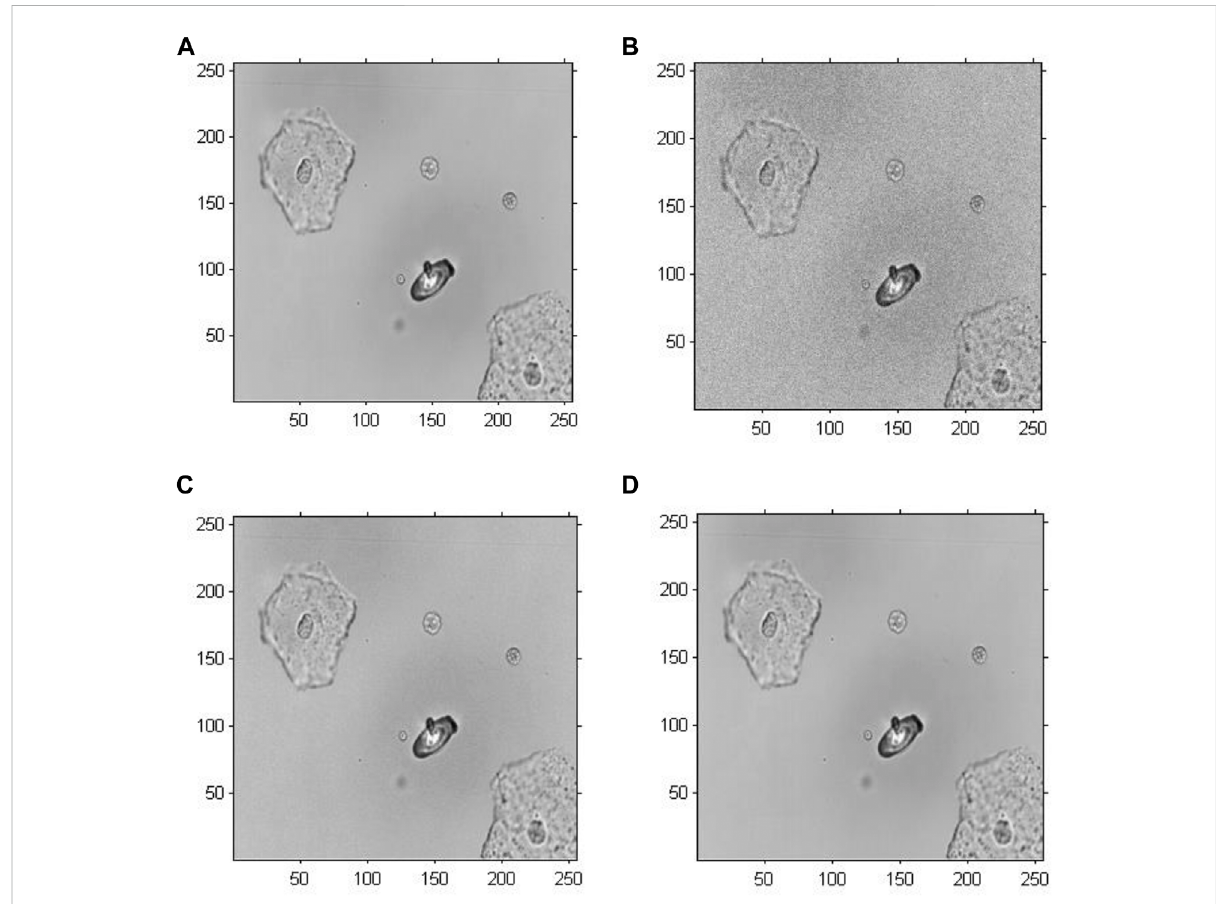
FIGURE 5 Amplitude reconstruction-based holographic image for Model 1. (A) Original greyscale image, (B) 20 iterative reconstruction images of amplitude information, (C) 200 iterative reconstruction imagesof amplitude information, and (D) 2000 iterative reconstruction imagesof amplitude